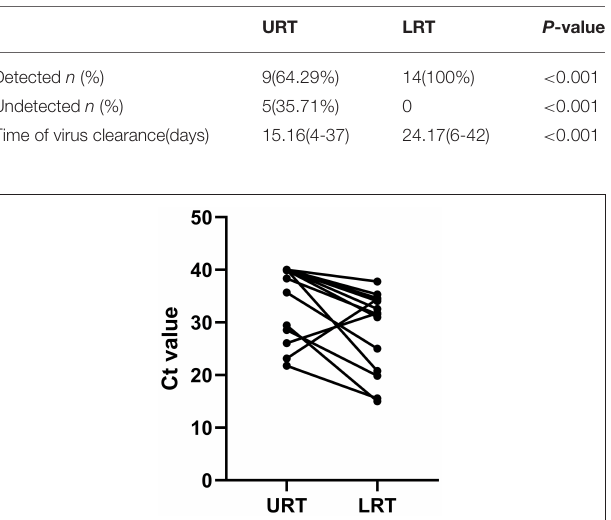
FIGURE 4 | Comparison of the Ct value between URT and LRT samples upon admission to the ICU. URT, upper respiratory tract; LRT, lower respiratory tract; ICU, intensive care unit; Ct, cycle threshold.